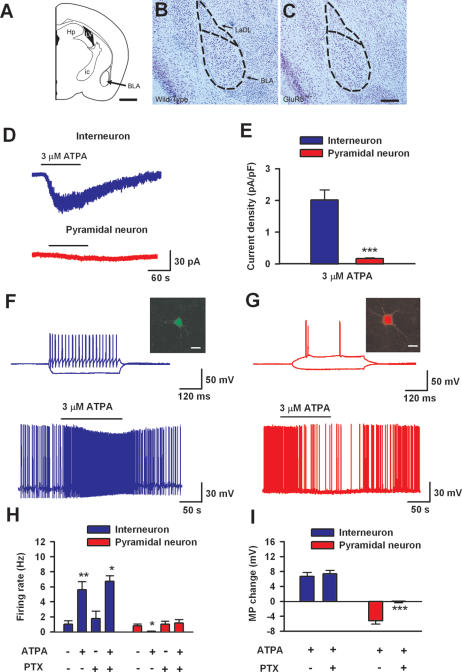
Activation of GluR5 increased neuronal excitability in interneruons but decreased excitability in pyramidal neurons.(A) Schematic organization of a parasagittal hemisection through a mouse brain depicting the approximate anatomical location where immunocytochemistry was conducted. (B and C) Nissl-stained coronal section through the BLA of representative wild-type (B) and GluR5−/− (C) mice. No obvious anatomical differences between these two strains were detected. (D and E) ATPA (3 µM)-induced current in interneurons (n = 5) is significantly larger than that observed in pyramidal neurons (n = 6). (F) Interneurons were identified by their morphology and firing properties. Lucifer yellow (0.1%) was loaded through the patch pipette and confocal images were obtained after recording. A representative interneuron is shown in the inset (scale bar, 20 µM). When injected with current steps that ranged from −100 pA to 100 pA within 400 ms, interneurons showed fast spiking properties (top trace). In the same neuron, bath application of ATPA (3 µM) induced neuronal depolarization and firing of the interneuron (lower trace). Resting membrane potential for this neuron is −52.3 mV and holding current is 18.5 pA. (G) Pyramidal neurons showed different firing properties from those observed in interneurons after current injection (top trace; representative shown in the inset, scale bar, 20 µM). In the same neuron, bath-application of ATPA (3 µM) induced hyperpolarization and reduced the neuronal firing (lower trace). Resting membrane potential for this neuron was −66.6 mV and the holding current was 66.9 pA. (H) Pooled data showed that ATPA (3 µM) increased firing rate of interneurons (n = 6) while decreased that of pyramidal neurons (n = 5). Bath application of picrotoxin (100 µM) completely blocked the effect of ATPA in pyramidal neurons but not in interneurons. (I) Bath application of picrotoxin (100 µM) completely abolished the hyperpolarization in pyramidal neurons (n = 5) but not depolarization in interneurons (n = 5) induced by ATPA (3 µM). * P<0.05, **P<0.01.